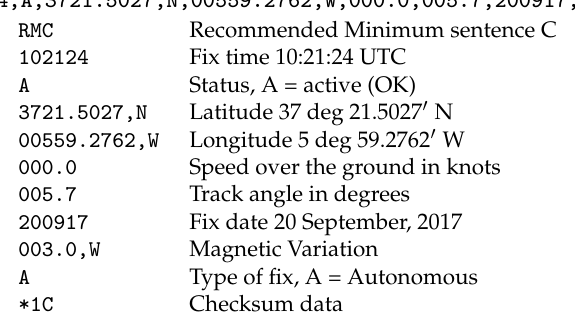
Figure 7. Sample national marine electronics association specifications (NMEA)-0183 recommended minimum sentence C (RMC) frame with decoded fields. Figure 7. Sample NMEA-0183 RMC frame with decoded fields.